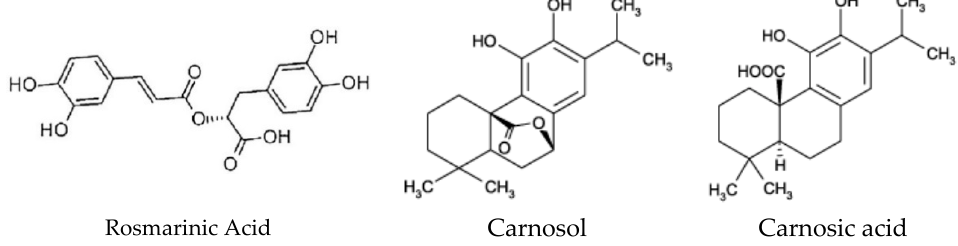
Figure 1. Chemical structure of the major antioxidative compounds in rosemary extracts.